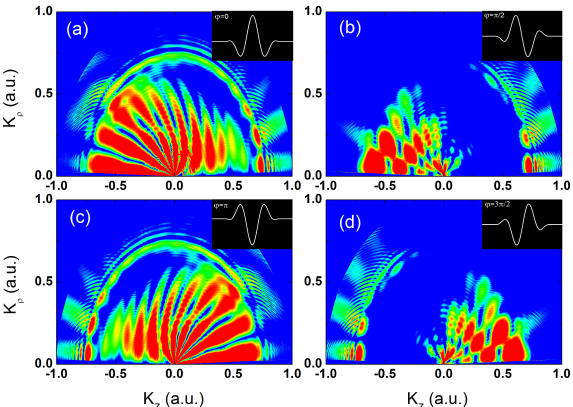
Figure 7. (Color online) Photoelectron momentum spectra of H(1 s ) state ionized by 6 fs pulsed laser with the intensity 7.0 × 10 13 W/cm 2 in the wake of carrier phase: ( a ) ϕ = 0, ( b ) ϕ = π /2, ( c ) ϕ = π , ( d ) ϕ = 3 π /2. Insets display the profiles for ± sine-like and ± cosine-like pulsed laser. For cosine pulses the fringes exhibit a left-handed roll structure for electron emission under the 0-phase field while in the opposite phase a right-handed roll structure is